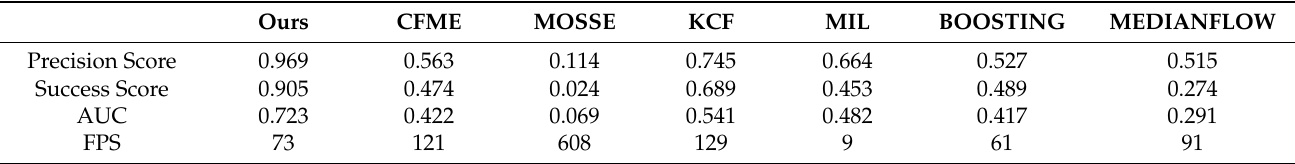
Figure 10. Precision plot and success plot. The values in legends are the AUC. ( a ) Precision plot of video4. ( b ) Success plot of video4. Table 6. Results of video4. Table 6. Results of video4.